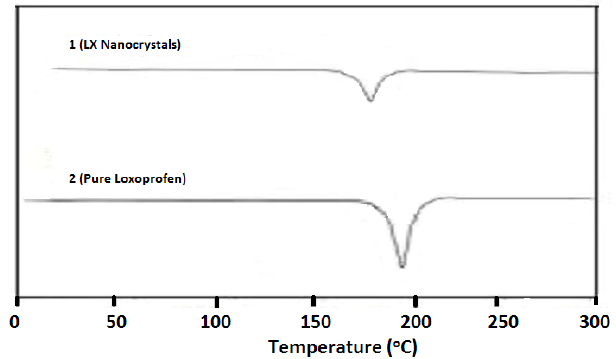
Figure 2. DSC studies of LX NCs ( 1 ) and pure powder ( 2